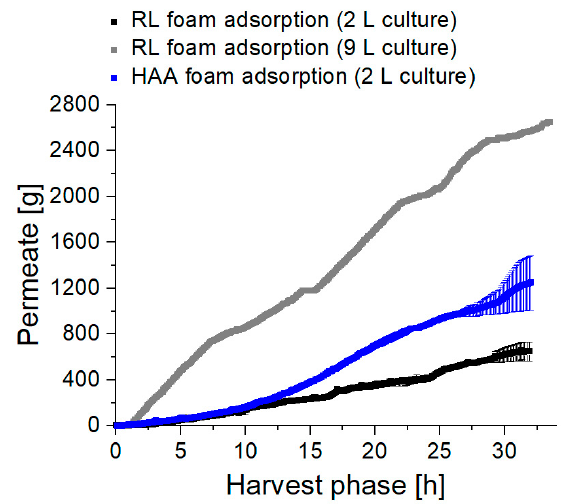
Figure 9. Weight of permeate collected after the adsorption column over the course of the harvest phase. Permeate trends in a 2 L working volume for the RL synthesis (black), and HAA synthesis (blue). The error bars indicate the deviation from the mean of two biological replicates. The permeate trend for RL synthesis in a 9 L working volume is plotted in gray.